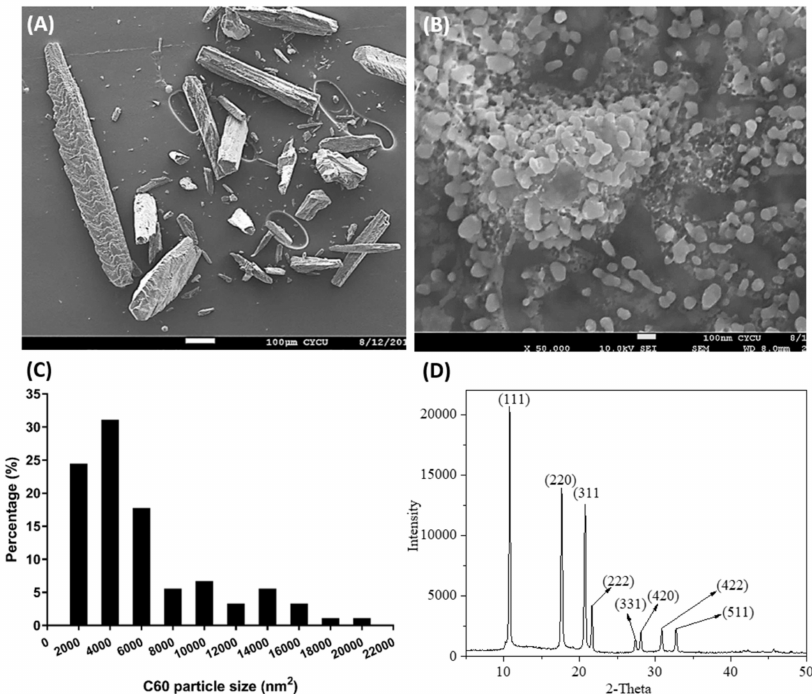
Figure 2. Characterization of the C 60 NPs used in this study. ( A ) SEM (scanning electron microscope) micrograph of C 60 NPs stock solution in the absence of solvents; ( B ) C 60 NPs dissolved in DMSO (dimethyl sulfoxide) showing a wide disparity in aggregation; ( C ) Size distribution of C 60 NPs dissolved in DMSO; ( D ) X-ray diffraction patterns of the crystal quality of the C 60 NPs.